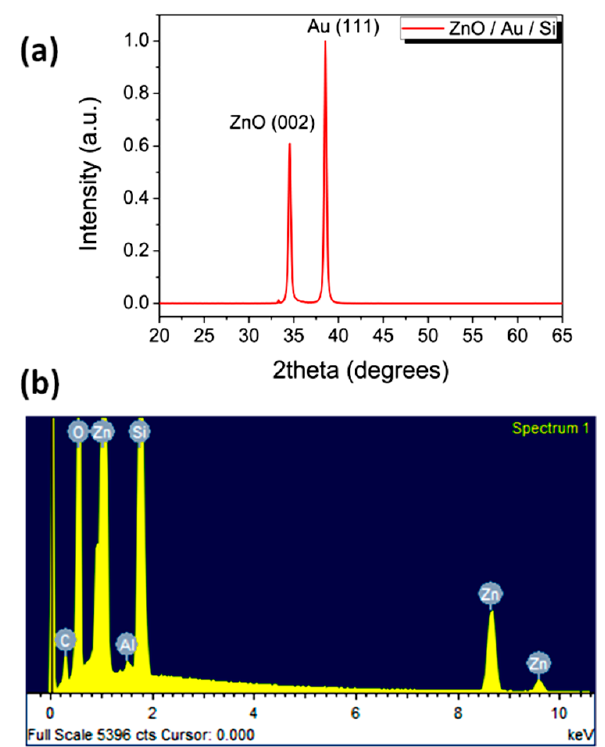
Figure 3. ( a ) XRD pattern and ( b ) EDX spectrum of sputtered ZnO thin films.